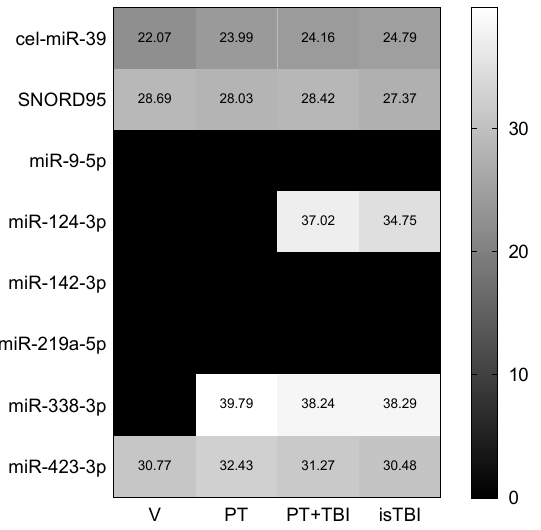
Figure 3. Detection profile of exogenous control cel-miR-39, housekeeping gene SNORD95 and target genes hs-miR-9-5p, -124-3p, -142-3p, -219a-5p, -338-3p and -423-3p stratified by injury pattern.